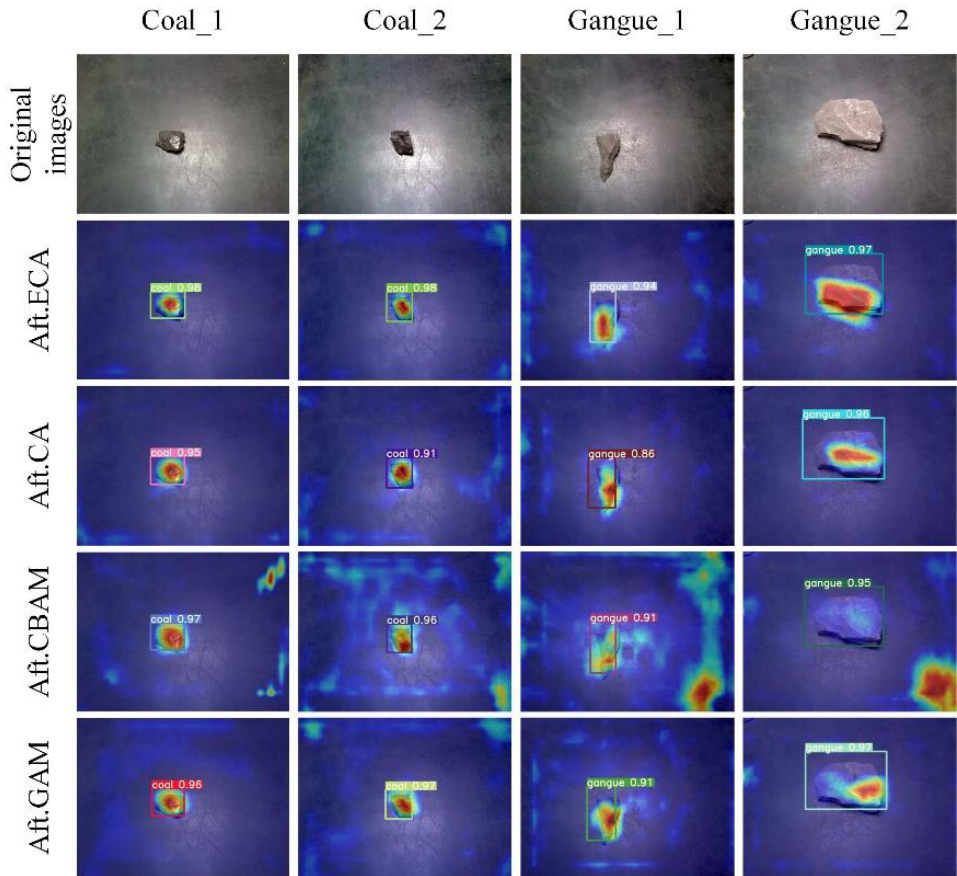
Figure 9. Visualization of feature maps using different attention mechanisms.